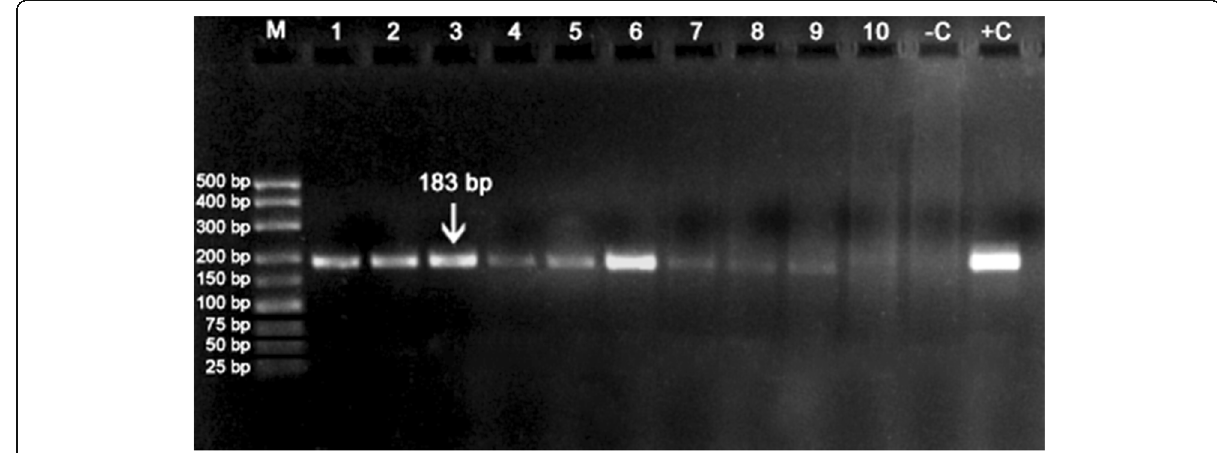
Fig. 1 Different PCR products representing chicken species adulteration of beef meat products. Lane M is 25 – 500 bp ladder or size marker. Beef burger samples: lanes 1, 2 and 3; oriental beef sausage samples: lanes 4, 5 and 6. Beef kofta samples: lanes 7 and 8. Luncheon samples were in lanes 9 and 10. − C and +C are negative and positive controls for chicken meat, respectively. Positive results are indicated by a band of 183 bp of mitochondrial 12S rRNA gene amplification for